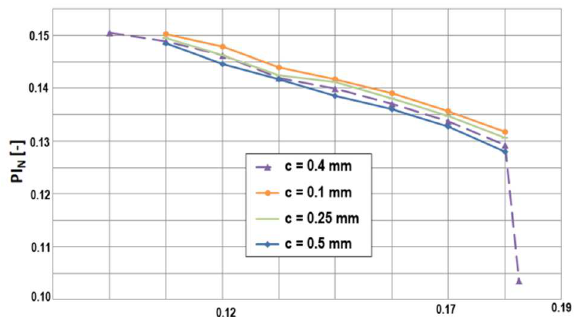
Fig. 12. Computed pressure characteristics for various width of seal clearance